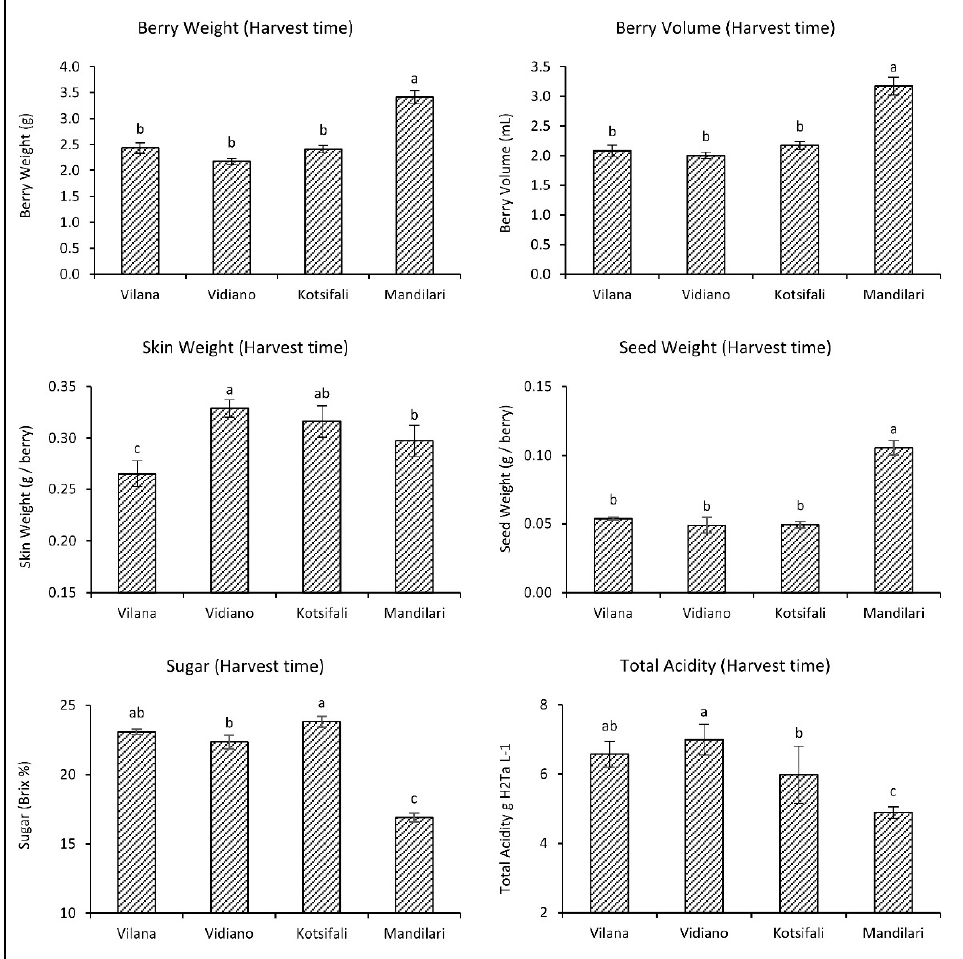
Figure 1. Physicochemical characteristics of Vilana, Vidiano, Kotsifali and Mandilari cultivars on harvest day. The error bars represent the standard errors of the means. Different letters indicate statistically significant differences among cultivars, according to Duncan’s multiple range test ( p ≤ 0.05). Table 2. Phenolic content, antioxidant activity, anthocyanins, total flavanols, total flavonols and trans- resveratrol content in the skin of Vilana, Vidiano, Kotsifali and Mandilari cultivars on harvest day.